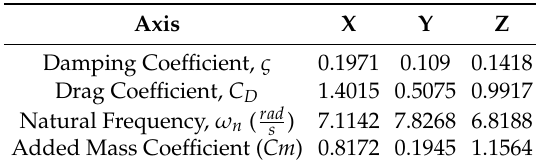
Figure 18. The behaviour of the value of the drag coefficient with respect to the speed in Reynolds number. Table 7. Values obtained in the free decay